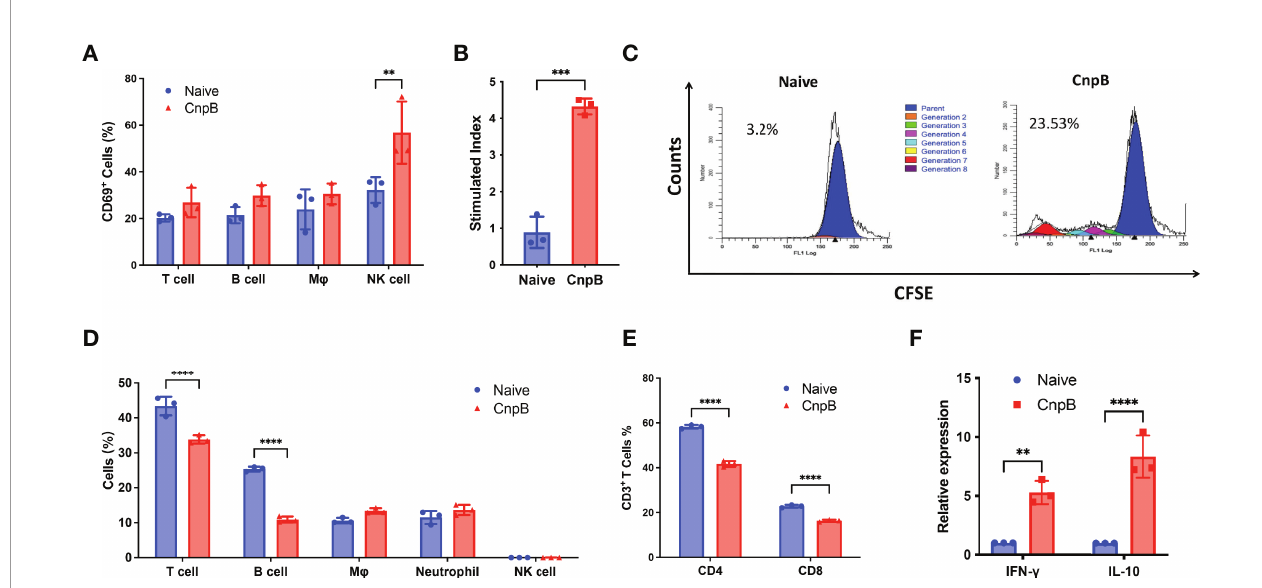
FIGURE 3 | Detection of cellular immune response in CnpB-immunized mice. (A) Proportions of immune cells in the spleens of CnpB immunized and naïve mice ( n =3). (B) The proliferation levels of splenocytes from CnpB immunized mice stimulated by PPD protein. Splenocytes were isolated from mice 4 weeks after the last CnpB immunization and analyzed for proliferation using an MTS assay ( n =3). (C) CFSE proliferation assay of splenocytes from CnpB immunized mice stimulated by CnpB. Flow cytometry was used to detect the proliferation of CFSE-labelled splenocytes, which were stimulated by 5 m g/mL CnpB proteins. The percentage numbers indicated the proportion of proliferating cells in total cells ( n =3). (D) The percentage of T cells, B cells, macrophages, neutrophils, and NK cells in the lungs of CnpB immunized mice ( n =3). (E) Percentage of CD4 + and CD8 + T cells in the lungs of CnpB immunized mice. ( n =3). (F) qRT-PCR was used to determine the relative transcriptional levels of Th1/Th2 cytokines, including IFN- g and IL-10, in lung tissue of CnpB immunized mice ( n =3). The results are expressed as the mean ± SD. ** P < 0.01, *** P < 0.001, **** P <